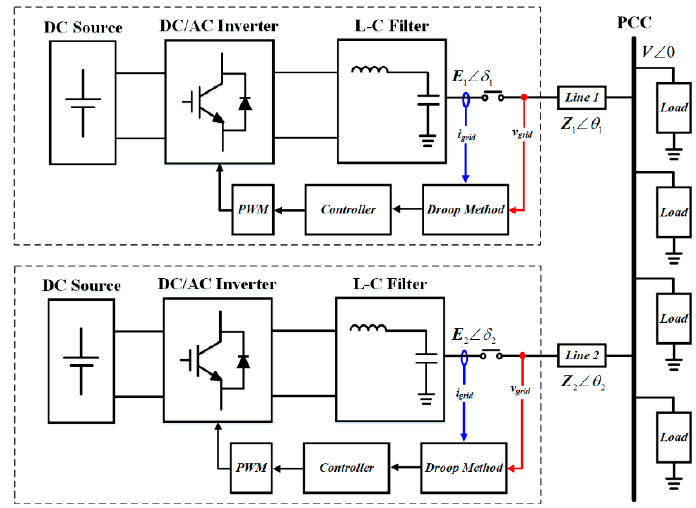
Figure 1. Schematic diagram of droop-controlled inverter-based MG.